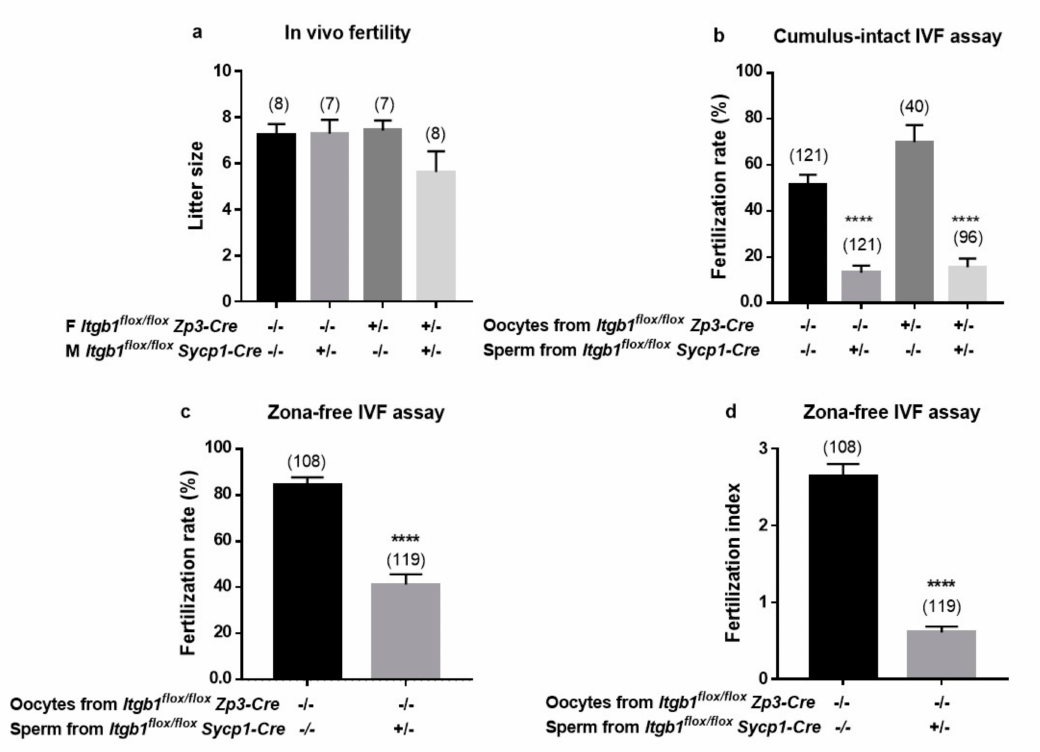
Figure 3. In vivo and in vitro analysis of the fertilizing ability of Sycp1-Cre +/ − Itgb1 flox / flox males (M) and Zp3-Cre +/ − Itgb1 flox / flox females (F). ( a ) histogram representing the mean litter size of